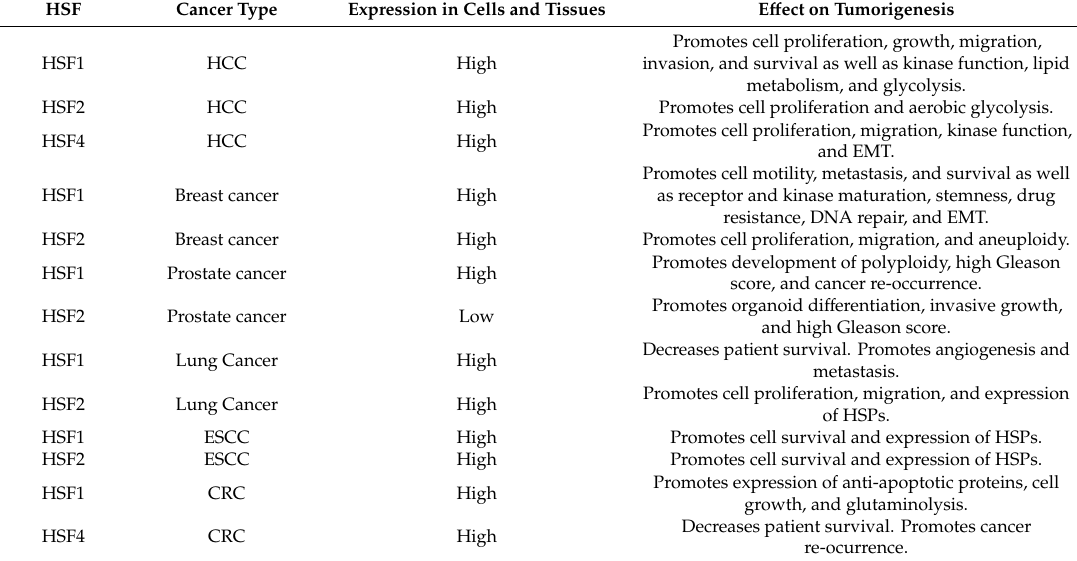
Table 1. Summary of HSFs expression and function in di ff erent types of